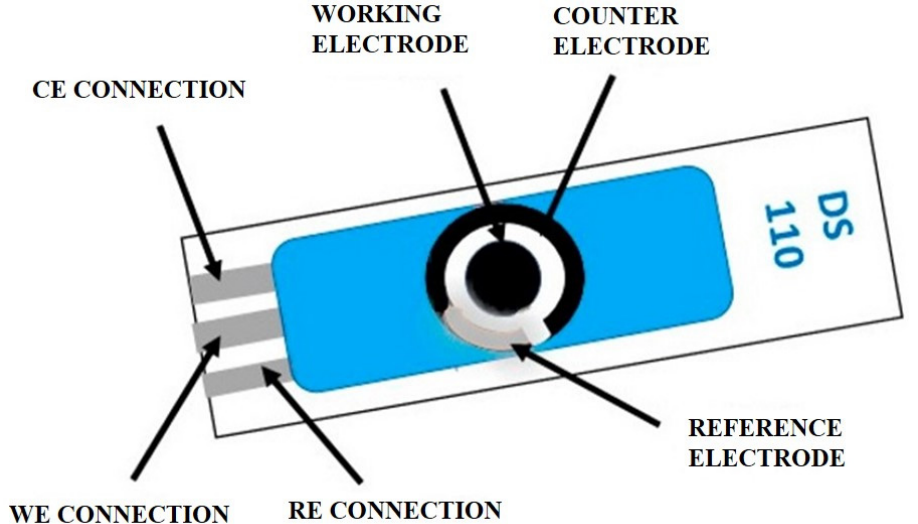
Figure 2. The most common scheme form of an SPE (adapted and reprinted with permission from [4]).